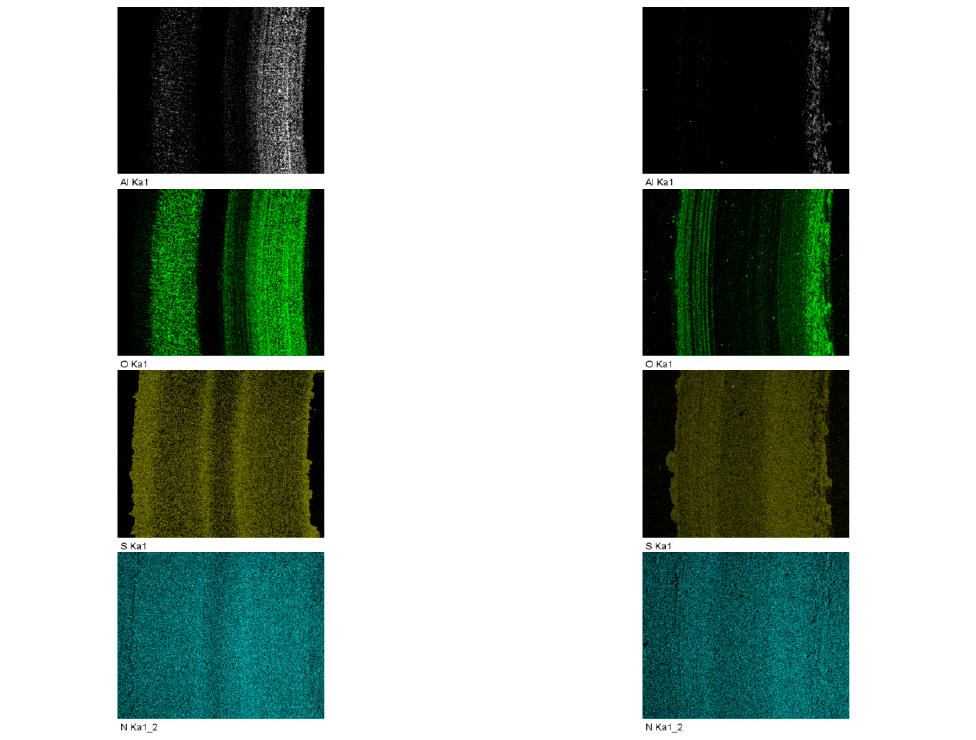
Figure 18. SEM images of wear traces (with energy dispersive X-ray spectrometer (EDS) mapping